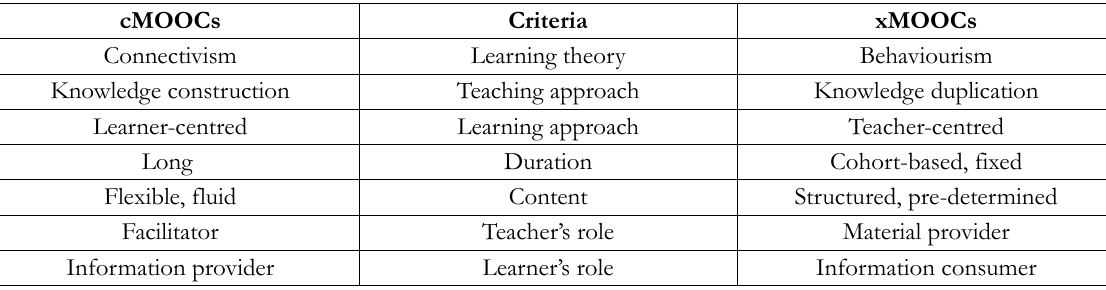
Table 1. Comparisons between cMOOCs and xMOOCs (Hollands & Tirthali, 2014; Saadatdoost et al.,